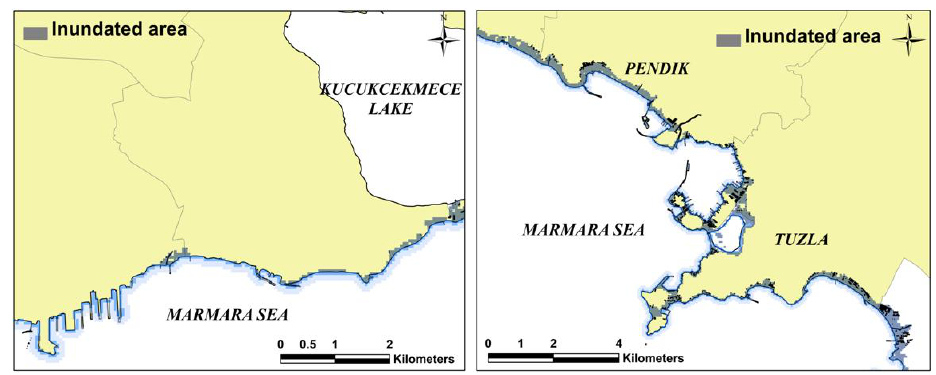
Figure 12. Inundated areas within two important industrial/commercial zones of Istanbul. Left panel: Ambarlı Port area and its vicinity, Right panel: Tuzla Bay area and the Tuzla shipyards.